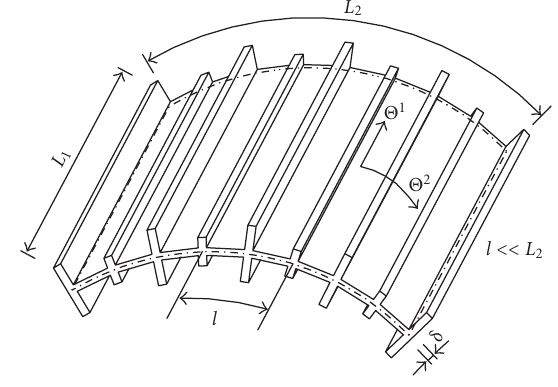
Figure 6.1. A shell with two families of uniperiodically spaced ribs.